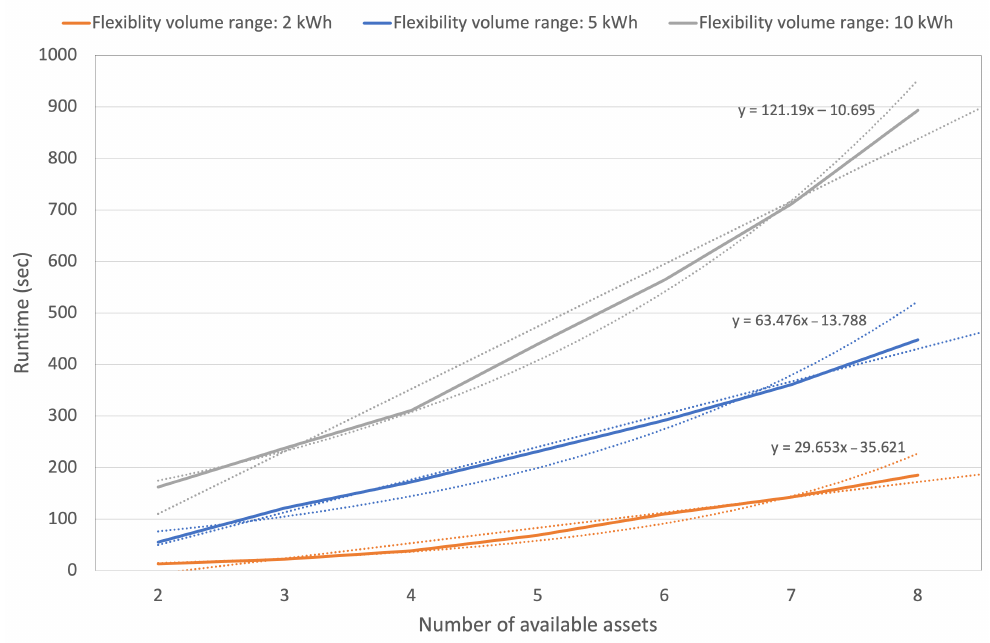
Figure 6. Runtime of the proposed DR framework as a function of the available